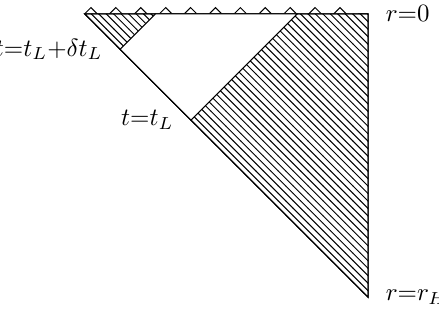
Figure 5. The (cid:14) WdW region, shown unshaded. At late times, it was argued in [20, 21] and veri(cid:12)ed in [23, 24] that this region controls _ C V